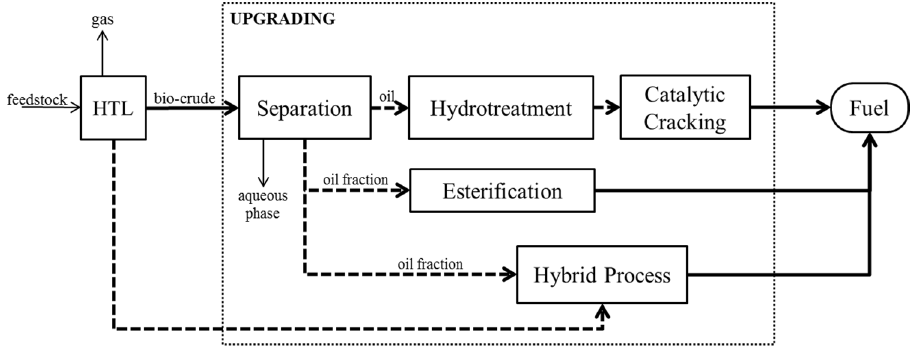
Figure 2. Block diagram of upgrading processes discussed in this